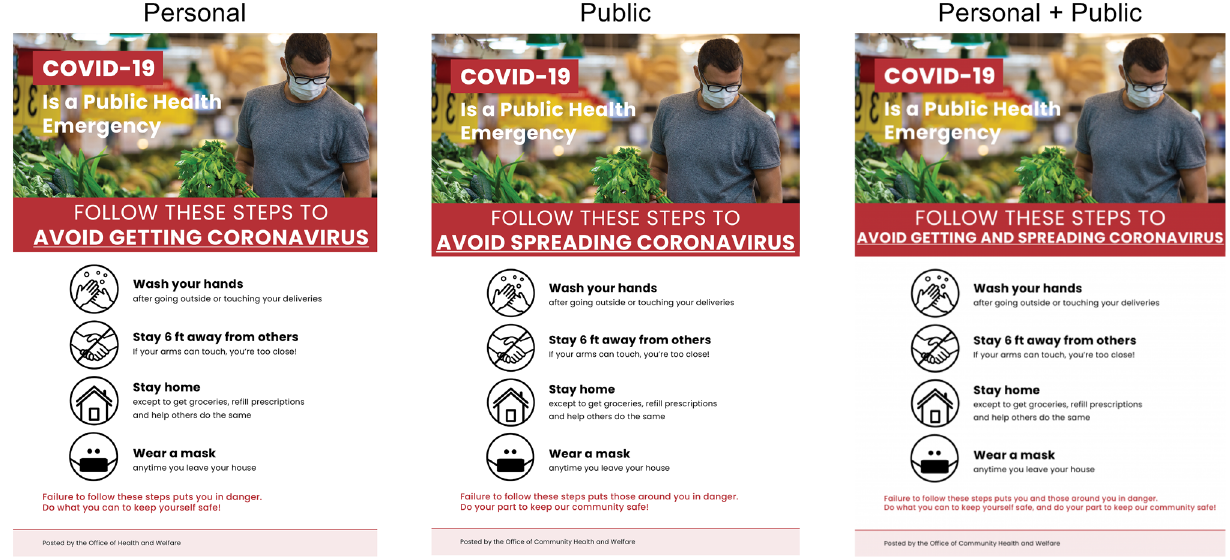
Figure 4. Fliers shown in each treatment across Studies 3a–d. Photograph attribution: